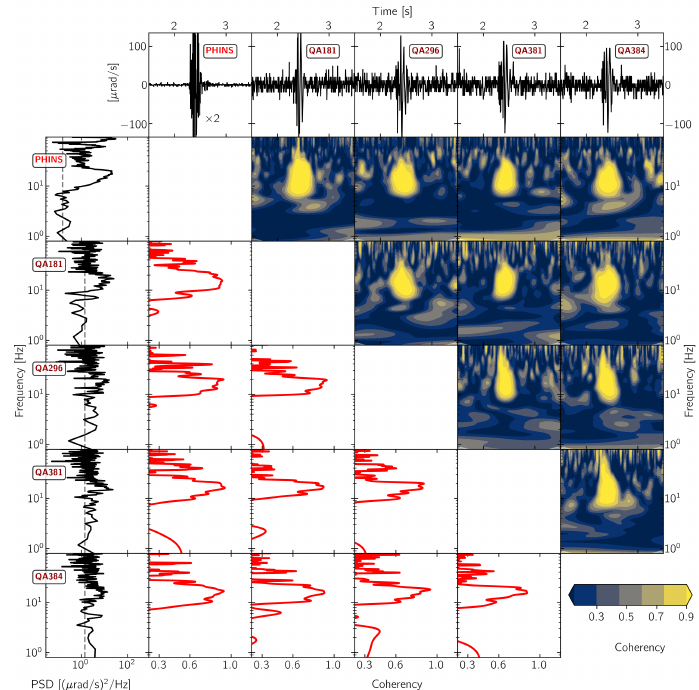
Figure 7. Waveform coherency for pairs of 6C strong motion sensor. The North component recording from explosion “expl2” on 19 November 2019 at 15:16:45 UTC (see Figure 1) is shown. For more details see Figure